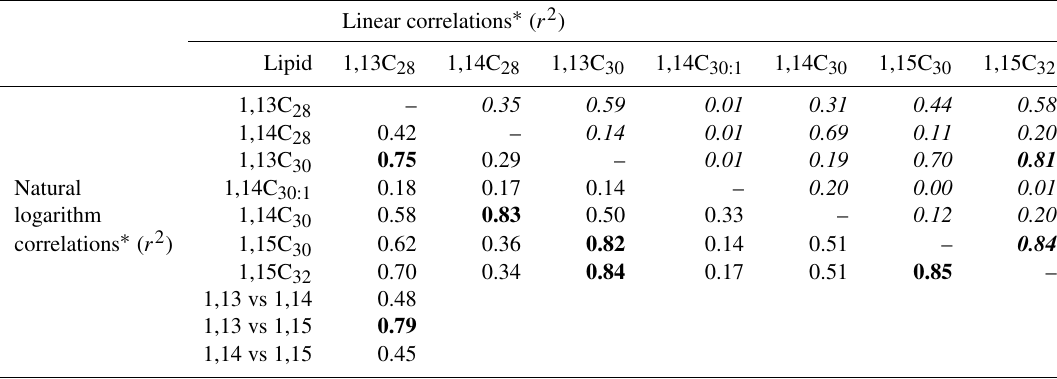
Table 3. Correlations of diol concentrations and their natural logarithms for CBeu1–5.